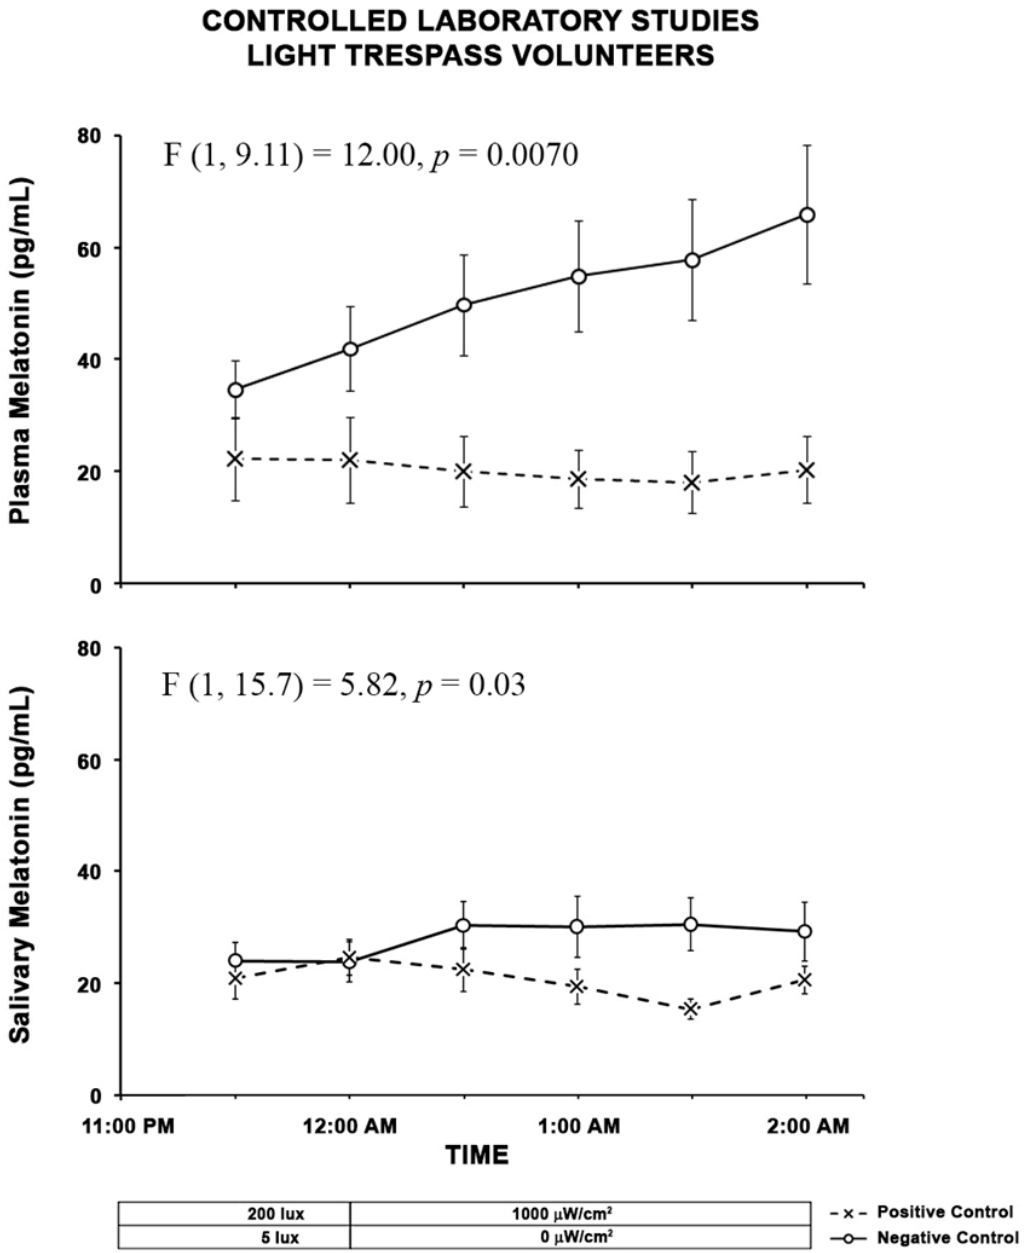
Figure 5. The two graphs above show results from subjects in the laboratory control studies. The O symbols represent the mean (± standard error of the mean, SEM) plasma and salivary melatonin levels during the negative control study when subjects were exposed to darkness from 12:00 A.M. to 2:00 A.M. The X symbols represent the mean ( ± SEM) plasma and salivary melatonin levels during exposure to 1000 µ W/cm 2 electric light from 12:00 a.m to 2:00 A.M. Statistical comparisons of melatonin values are for the exposure periods only (12:00 a.m to 2:00 A.M.) and are based on LMM. The main effects of the type of test (F (1, 9.11) = 12.00, p = 0.0070) and time (F (4,61.7) = 3.69, p = 0.0093) were significant for plasma melatonin suppression and for the salivary melatonin suppression, main effect of the type of test was significant (F(1, 15.7) = 5.82, p = 0.03). The AUC results are shown in Figure 6. Like the time-based curves, the negative con- trol levels are higher than the positive control levels, again demonstrating melatonin sup- pression due to bright light exposure in the positive control study. The differences in the